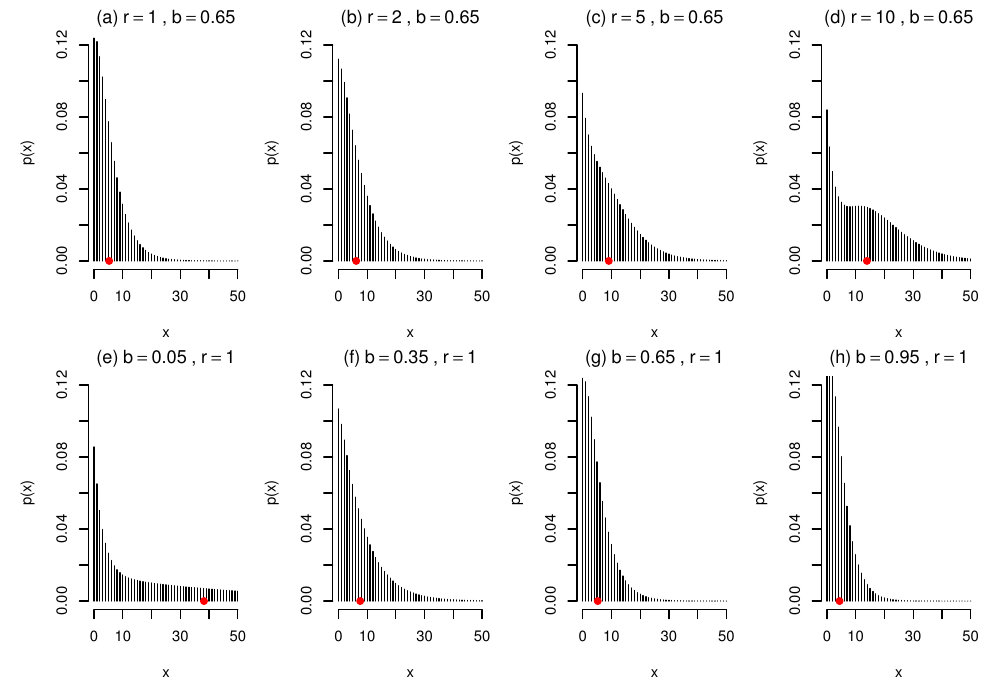
Figure 5. Shapes of the mass function (9) for different values of ( b , r ) and β = 0.4, with means indicated in red.